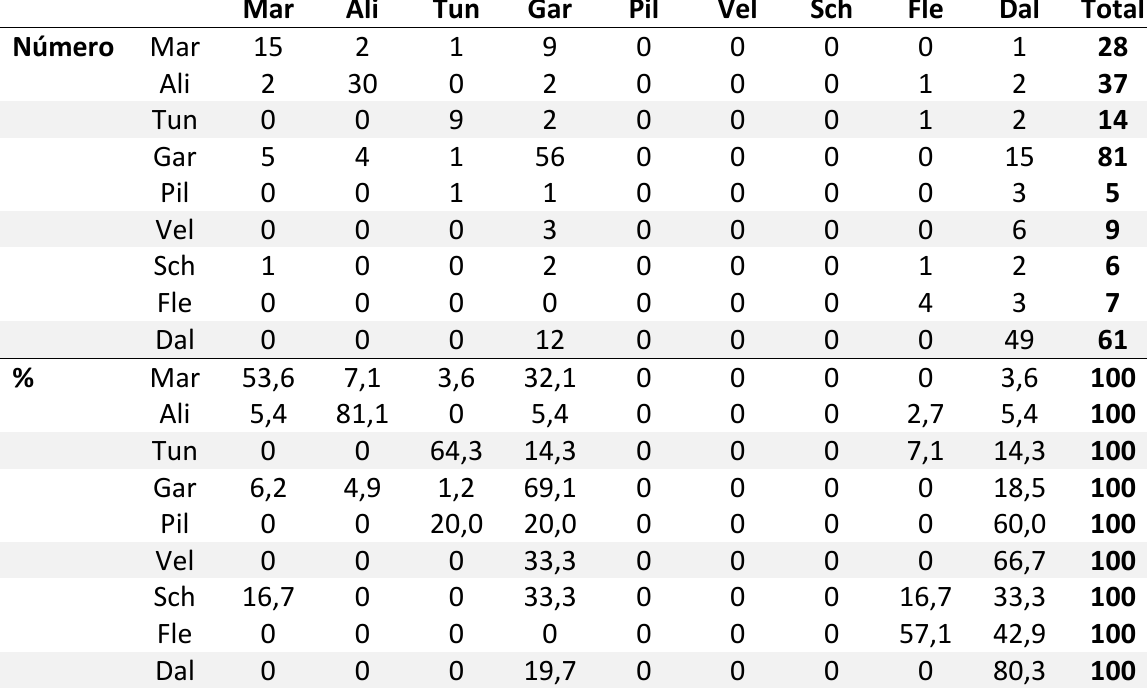
Table 9. Results of the classification of Discriminant Functions Analysis